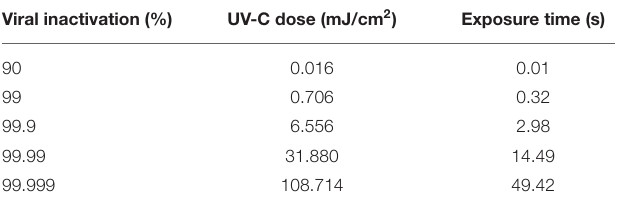
TABLE 2 | UV-C doses for SARS-CoV-2. Viral inactivation